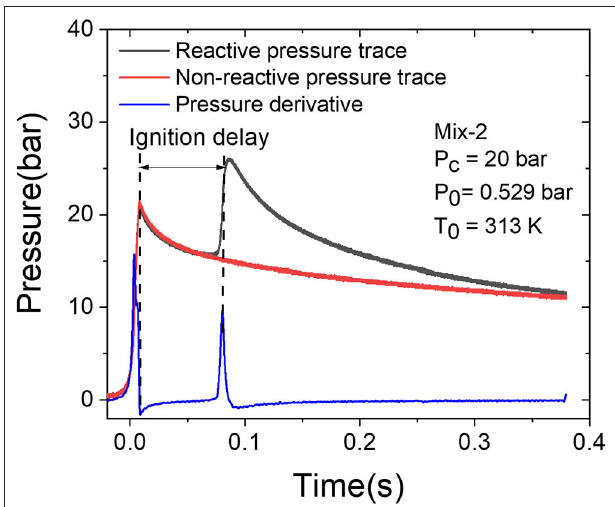
FIGURE 2 | Typical reactive pressure profile ( black solid line ) and the corresponding non-reactive pressure profile ( solid red line ) as well as the pressure derivative of reactive pressure for the determination of the ignition delay time ( blue solid line